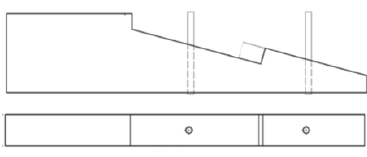
Figure 5. Geometry of a stop-splayed scarf joint ( ‘ Bolt of lightning ’ ).